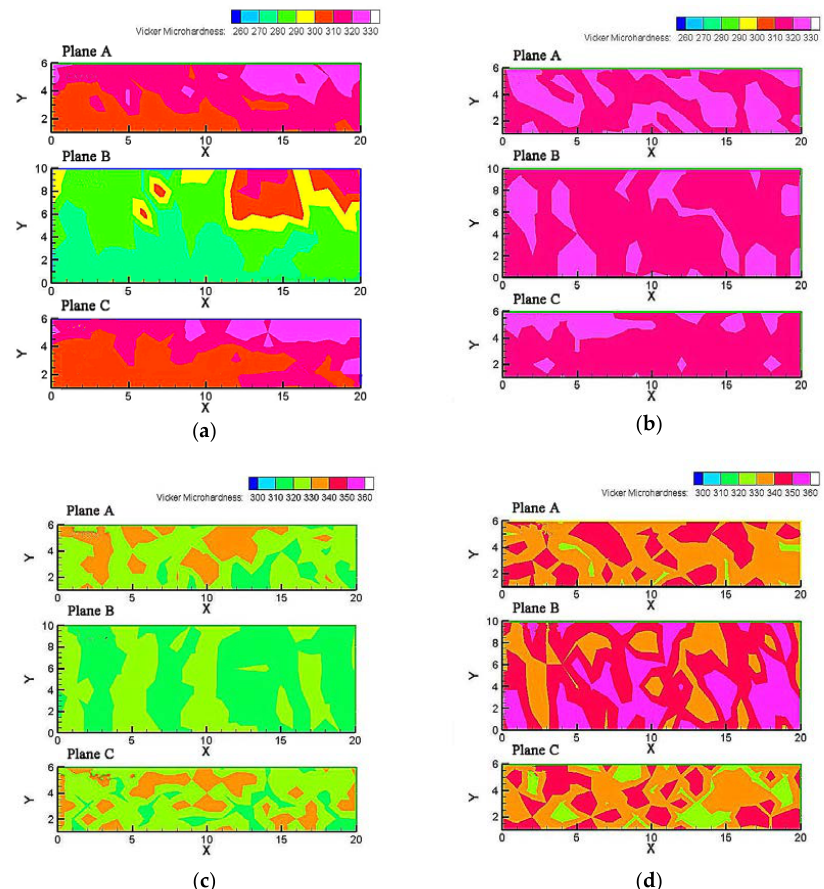
Figure 8. Color-coded contour maps showing Vickers microhardness distributions along various planes for the samples processed after different pass numbers: ( a ) 1 pass; ( b ) 3 passes; ( c ) 4 passes; and ( d ) 8 passes.